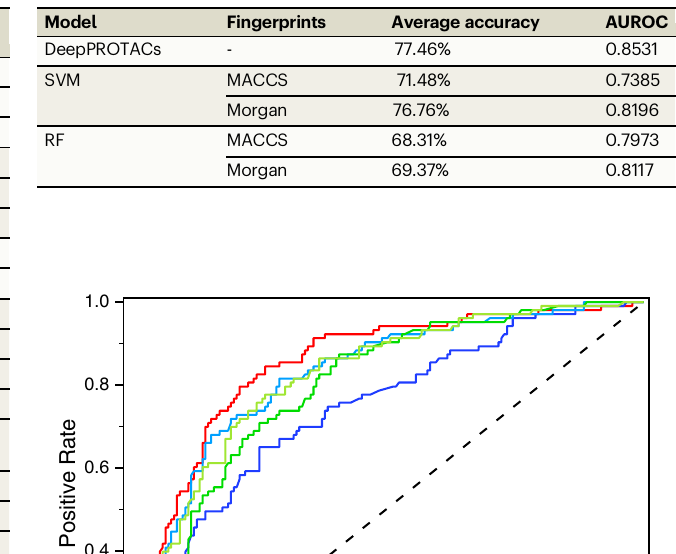
Table 3 | The evaluation results of DeepPROTACs, SVM, and RF models on test set